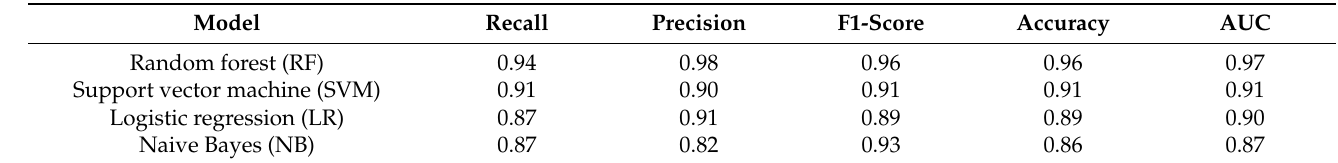
Table 4. Classification performance of the machine learning